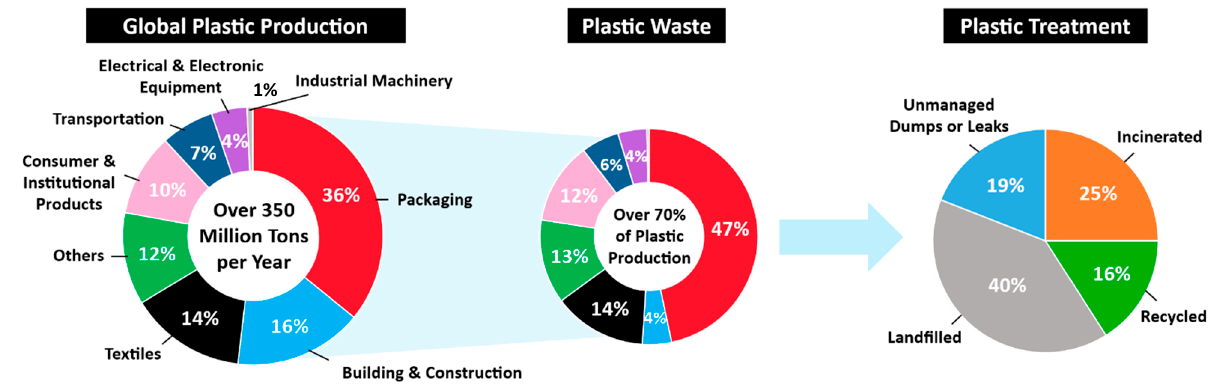
Figure 1. Global plastic production. The most plastic is destined for single use packaging. More than 240 million tons of plastic waste are generated every year. About 40% of plastic waste has accumulated in landfills and 25% has been incinerated [7,8].